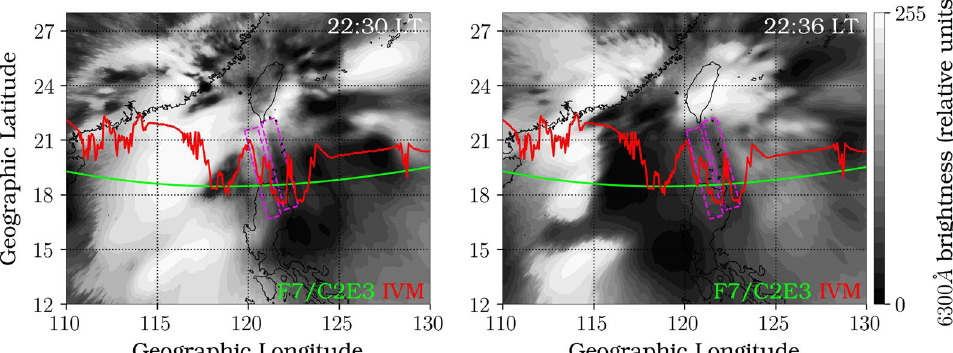
Fig. 9 Simultaneous observations of unwarped OI 630.0 nm airglow images with the ion density of F7/C2E3 (left) at 22:30 LT and (right) at 22:36 LT on 18 October 2020. The green and red curves indicate the F7/C2E3 orbit and ion density, respectively. The locations of the two weak plasma depletions in the images are highlighted using dashed